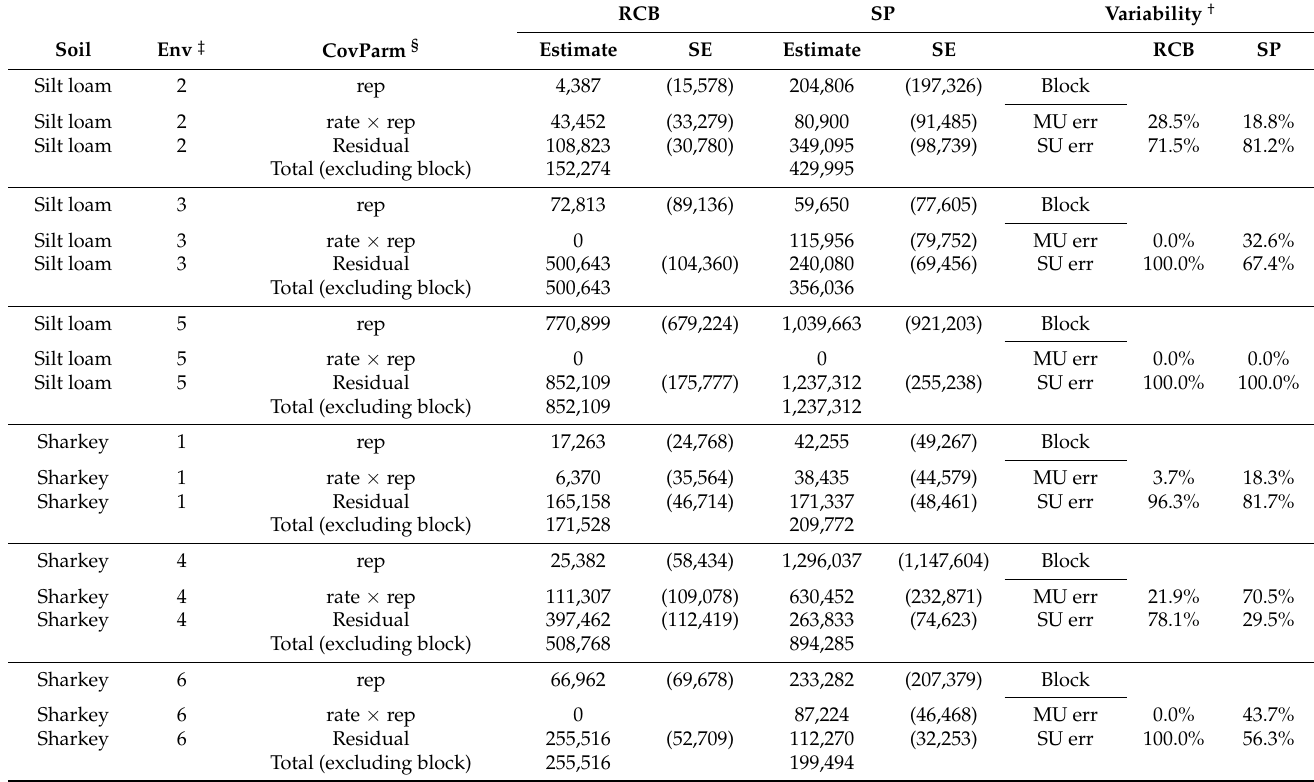
Table 2. Initial ANOVA estimates of variance and standard errors (SE) for random effects, covariance for random effects, and variability percentage described for main and subunit errors for an N rate response experiment comparing a split-plot (SP) design to a randomized complete block (RCB)